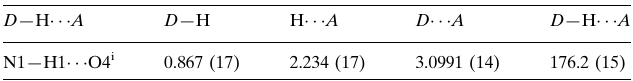
Hydrogen-bond geometry (A˚ , (cid:1)